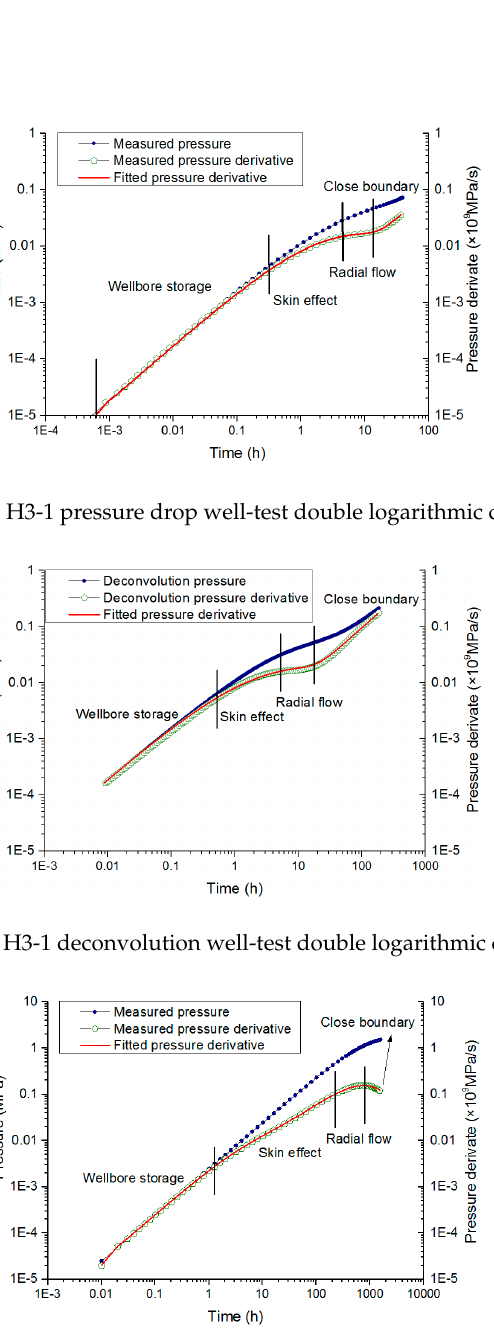
Figure 5. H3-2 pressure build-up double logarithmic curves.